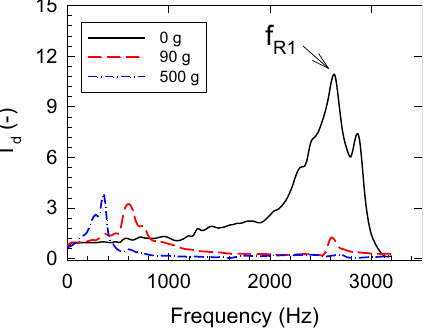
Figure 6: Frequency dependencies of the displacement transmissi - bility of the tested perlite/HDPE composites ( Inset: perlite concen - tration ) without inertial mass ( m = 0 g ) .